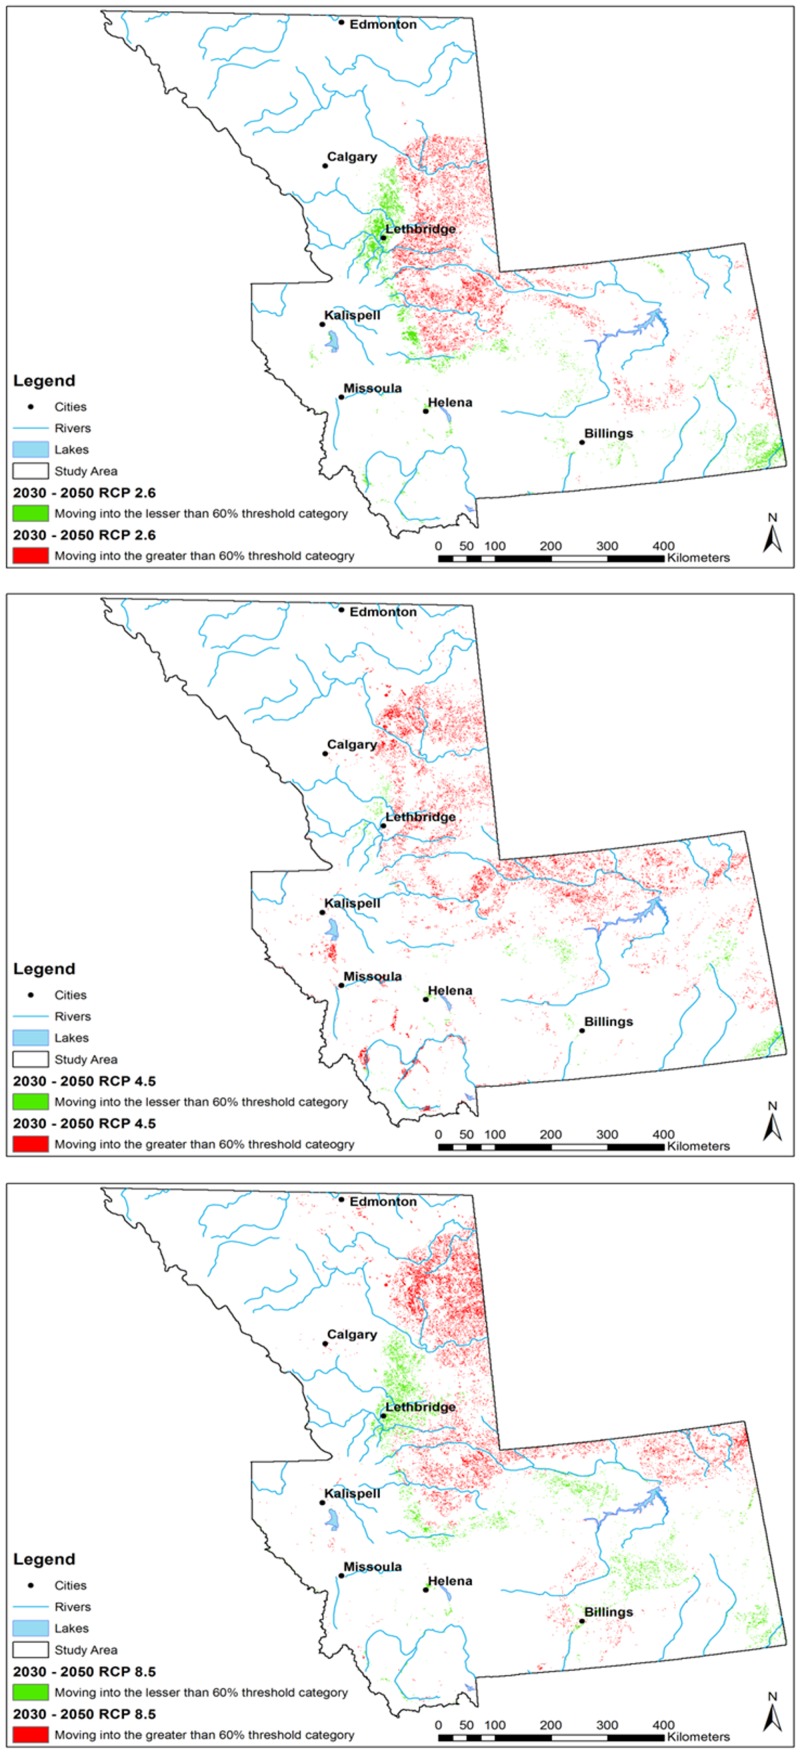
Maps of pixel change analysis into and out of 0.6 threshold category (expressed as percentage) for Culicoides sonorensis occurrence probability as predicted with the Maximum Entropy algorithm under different climate change scenarios (Representative Concentration Pathways, RCP) projected for 2030–2050.Each RCP is displayed (C) RCP 2.6; (B) RCP 4.5; (C) RCP 8.5. Green represents those areas moving into lesser than 60% probability threshold category, red represents those areas moving into the greater than 60% probability threshold category for Culicoides sonorensis occurrence.